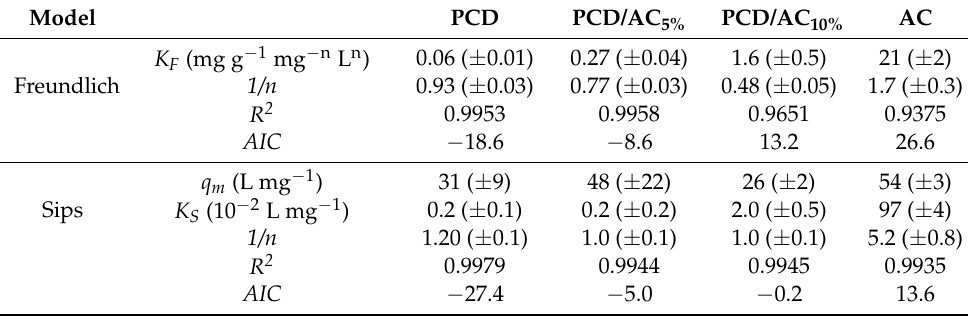
Table 5. Sorption fitting parameters for imidacloprid (see Figure 4).